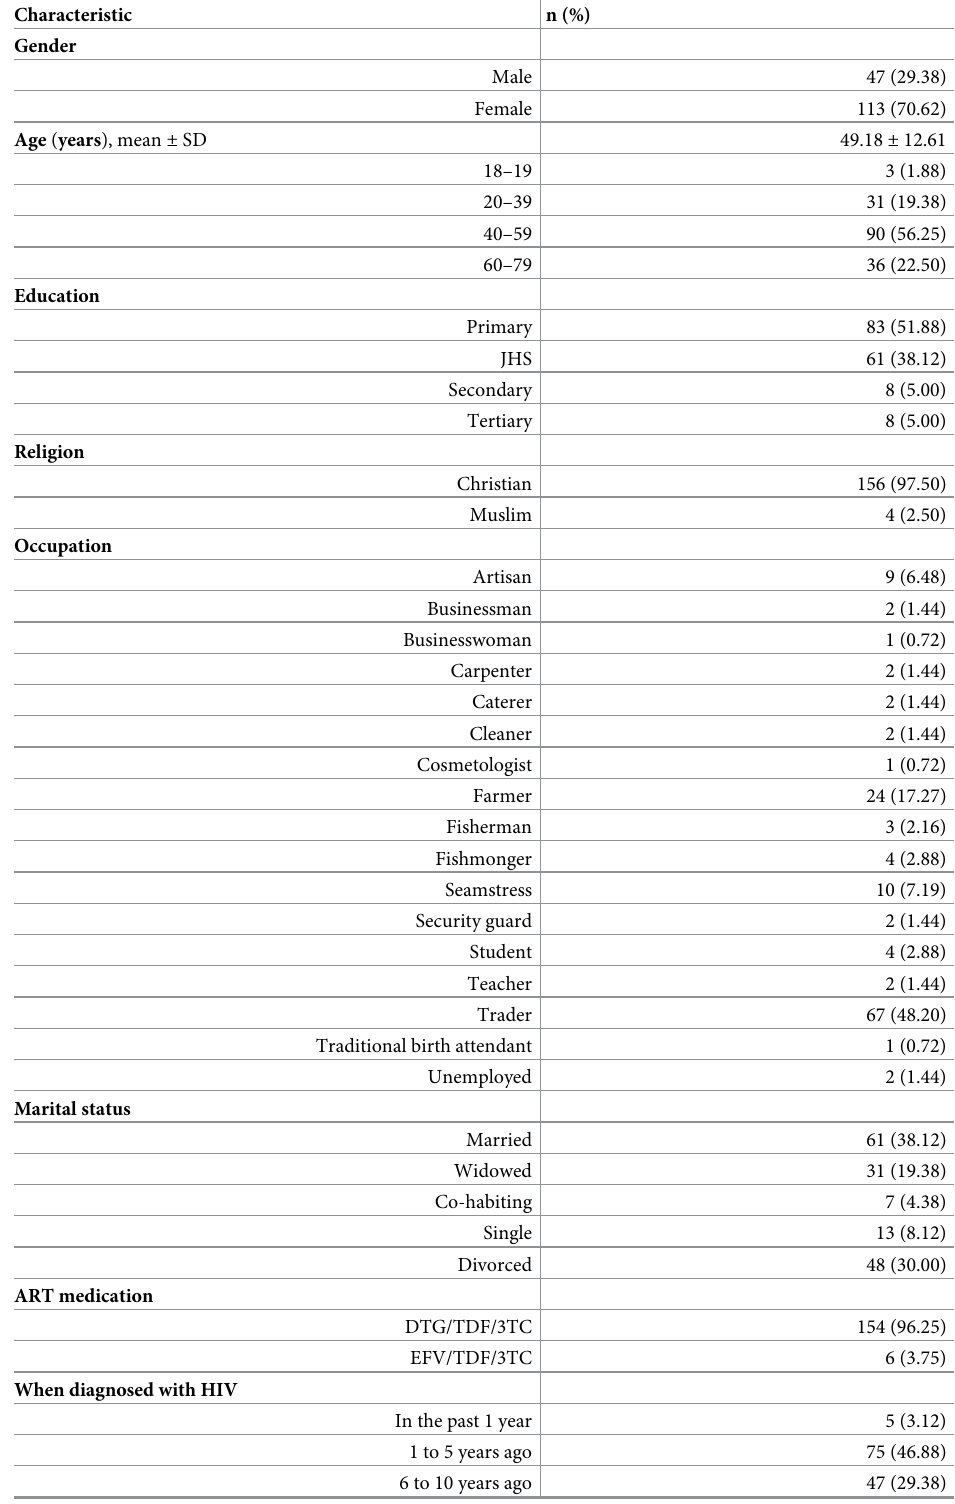
Table 1. Clinicodemographic characteristics of